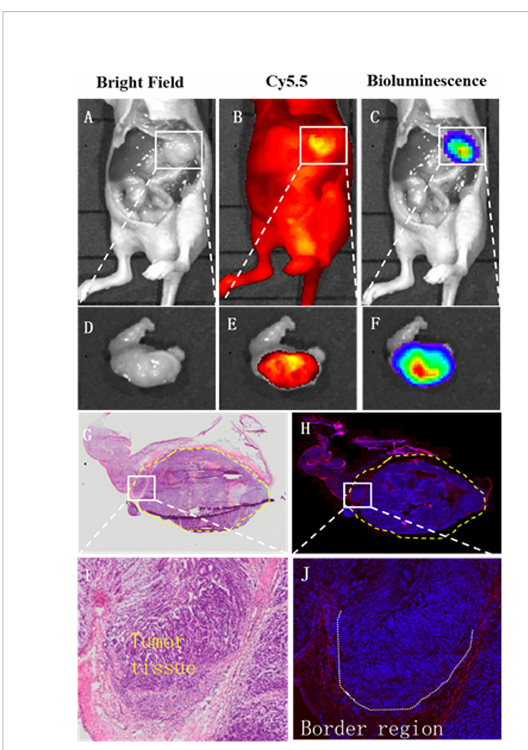
FIGURE 6 Intraoperative tumor margin assessment by (GEBP11) 2 -Acp- Cy5.5 probe. Compared with bright light imaging (A, D), (GEBP11) 2 -Acp-Cy5.5 probe enhanced tumor to normal tissue contrast under fl uorescence imaging in vivo and vitro (B, E), which was con fi rmed by bioluminescence imaging (C, F) . (G, H) Immunohistochemical staining and fl uorescence imaging showed a clear tumor positive circumferential resection margin (yellow dotted line). (I) Further microscopic histological analysis of the resected tissue clearly visualized border regions between tumor and surrounding healthy tissues, which was consistent with fl uorescence signals of (GEBP11) 2 -ACP-Cy5.5 (J) .